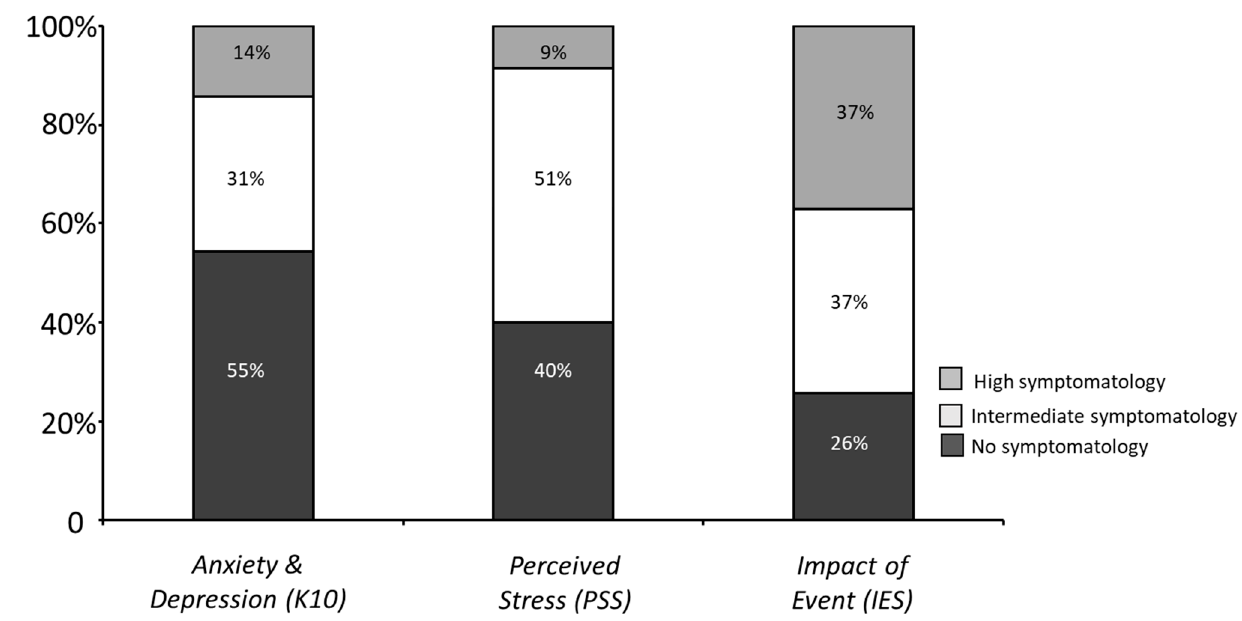
Figure 1. Frequencies of HCWs showing high, intermediate, and low symptomatology on the K10, PSS, and IES (anxious/depressive symptoms, perceived stress, and PTSD symptoms).